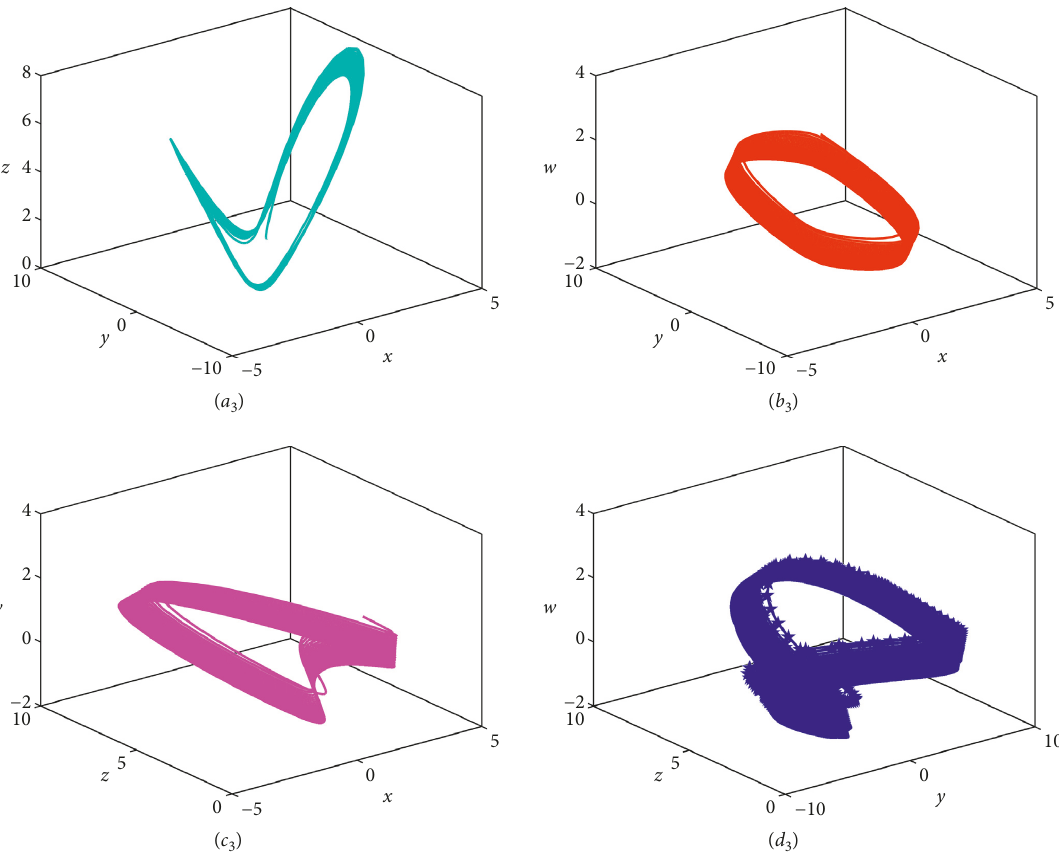
Figure 16: Phase portraits of Experiment 3 with a � 3 ,t � 3000: ( a ) in y − z − w ( d 3